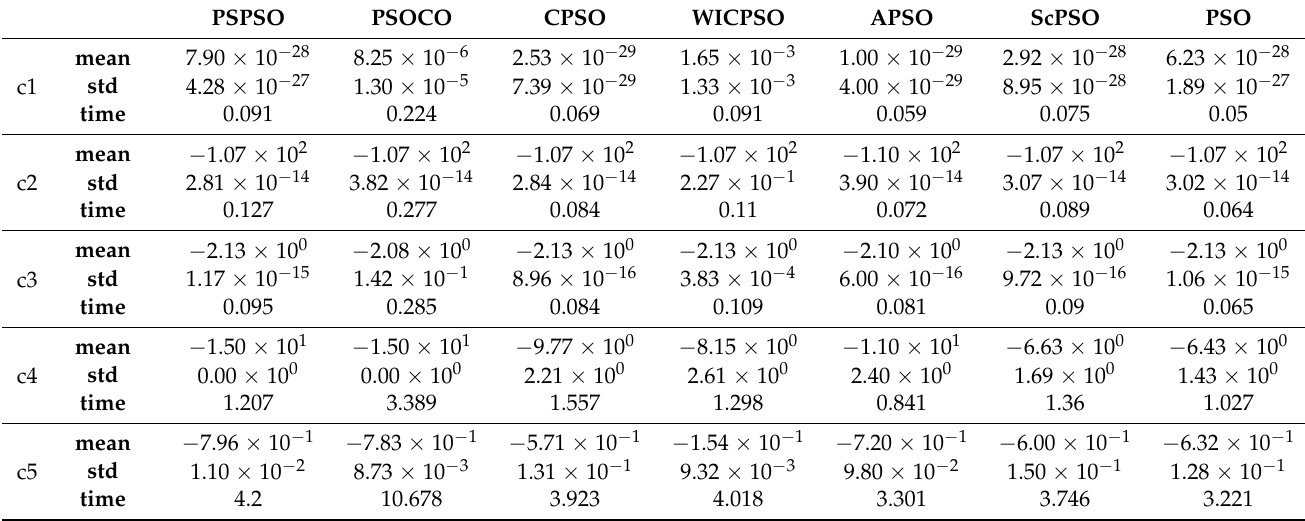
Table 9. Results of benchmark constrained functions.